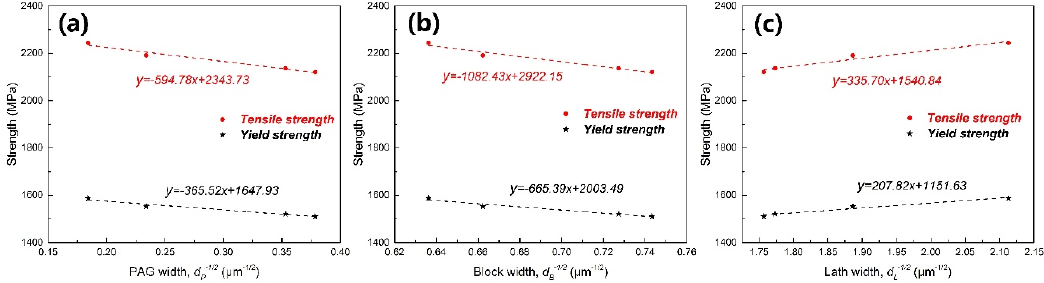
Figure 10. Strength as a function of ( a ) prior austenite grain (PAG) size ( d R ), ( b ) block width ( d B ), and ( c ) lath width ( d L ).